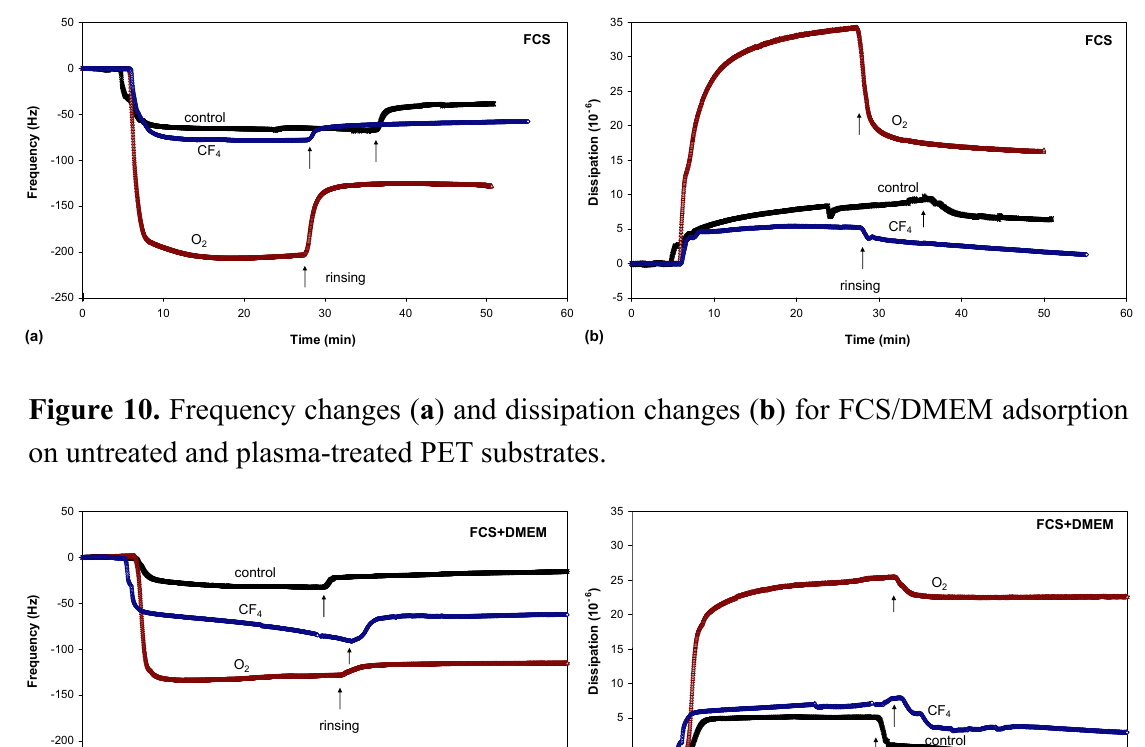
Figure 9. Frequency changes ( a ) and dissipation changes ( b ) for FCS adsorption on untreated and plasma-treated PET substrates.